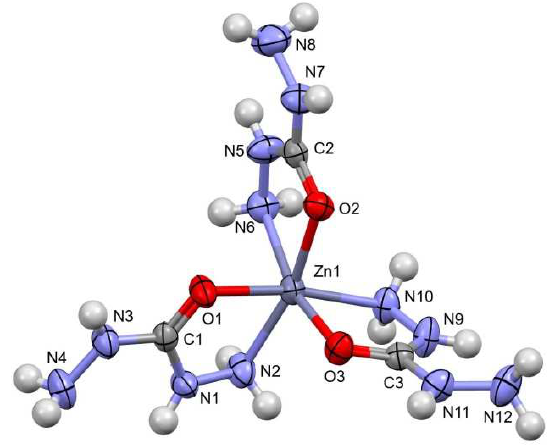
Figure 1. Molecular structure of 6 .